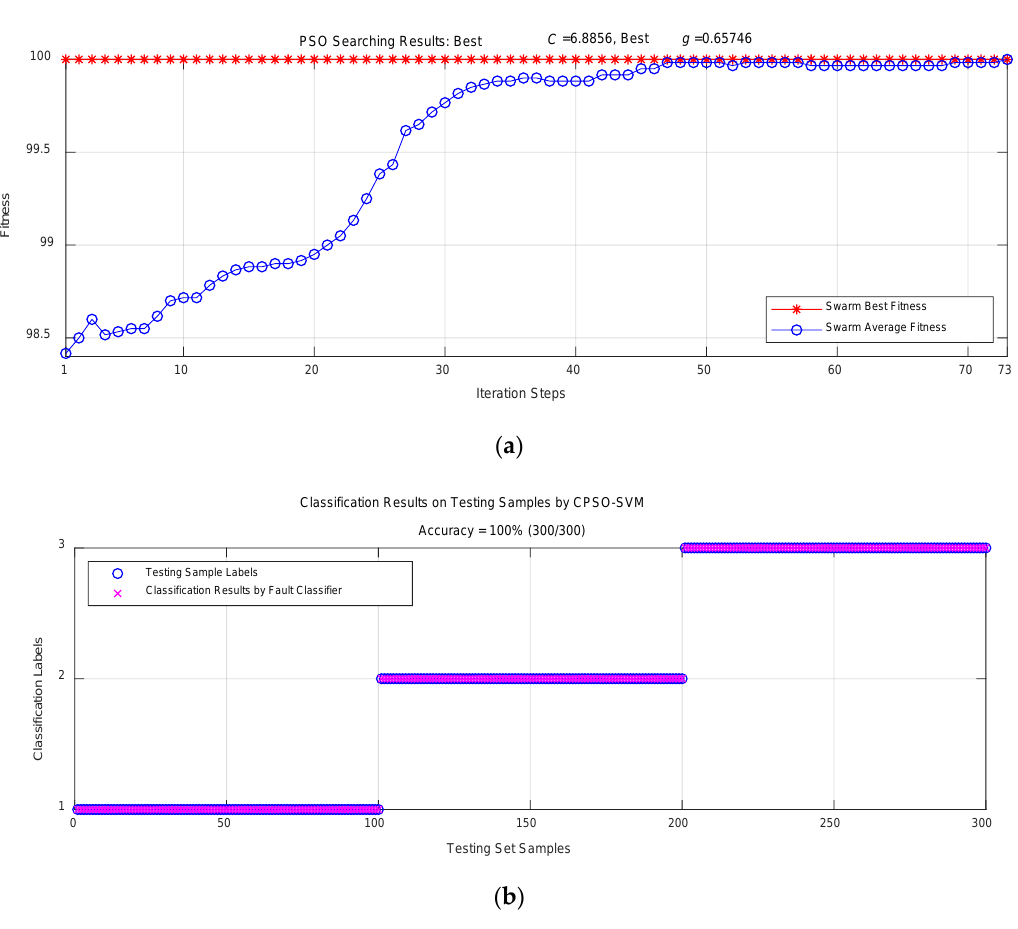
Figure 13. Fault classification results on testing set by CPSO-SVM with SVM parameters C = 6.8856 and g = 0.65746 optimized by CPSO. ( a ) Swarm average fitness evolving process along with iterations (73 iteration steps to converge with constant c 1 = c 2 = 1.5 and ω = 1 in PSO). ( b ) Fault classification results of CPSO-SVM (classification accuracy = 100%).